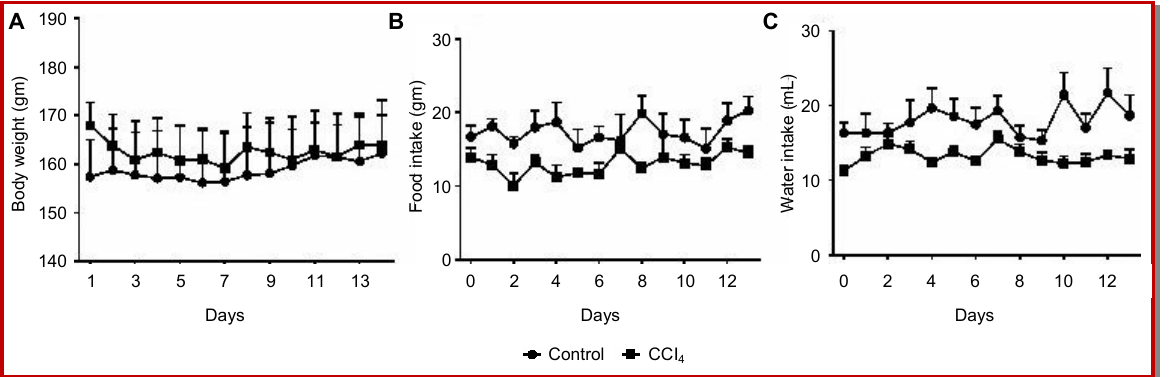
Figure 1: Effect of CCl 4 on body weight (A), food intake (B) and water intake (C) in rats. Values are presented as mean ± SEM. Student’s t tests were done for statistical comparison. Values are considered significance at p<0.05. a vs b, control vs CCl